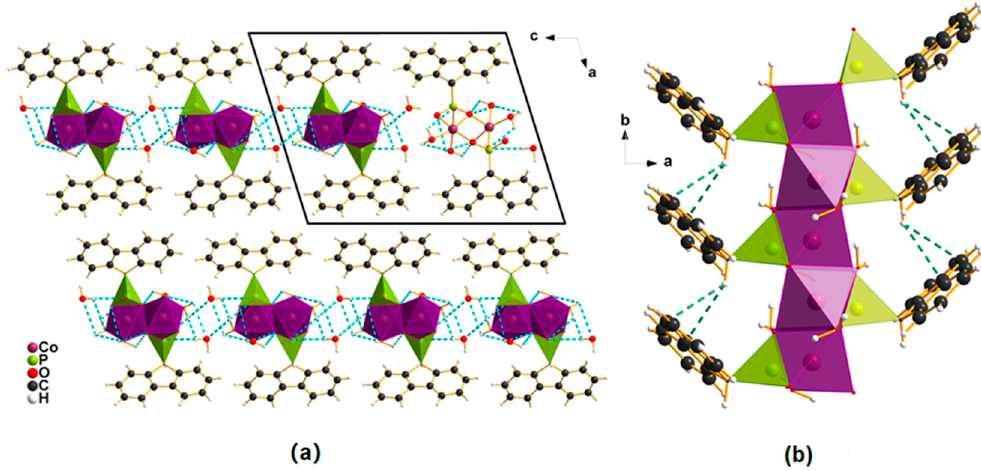
Figure 2. ( a ) Projection of the structure of Co(H 2 O) 2 PO 3 C–C 12 H 9 · H 2 O along the b axis. In blue dashed lines are represented the O–H ··· O hydrogen bonds between the H 2 O molecules, oxygen atoms of the cobalt octahedra, and PO 3 C tetrahedra, with H ··· O distances between 2.93 Å and 3.20 Å. The black square represents the unit cell. ( b ) Representation of one column along the c axis. The water molecules were removed in order to see clearly the π ··· π stacking between the fluorene moieties. The green dashed lines correspond to C–H ··· C interactions with H ··· C distances between 3.10 Å and 3.13